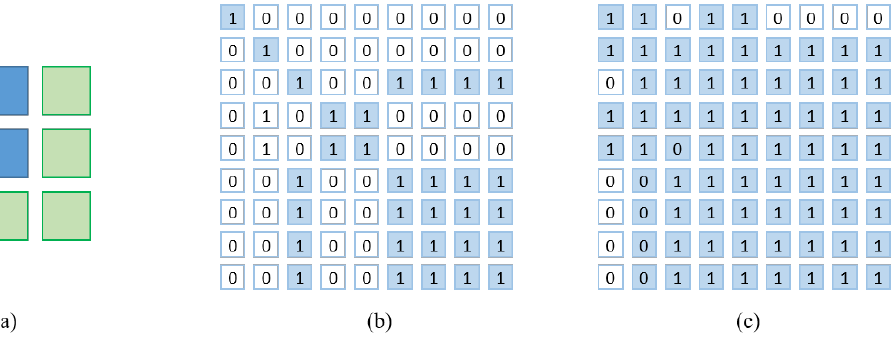
Figure 5. Illustration of the construction of the region affinity map (RAM). ( a ) shows the downsam- pled ground truth, with different colors representing distinct pixel categories. The RAM ( b ) represents the regional association between any two pixels in ( a ). A pixel’s relationship degree is one if they are in the same region. The image on the right ( c ) represents the region affinity map after boundary relaxation. Compared to ( b ), we regard the boundary pixels in each region in ( a ) to be part of the same region as the surrounding